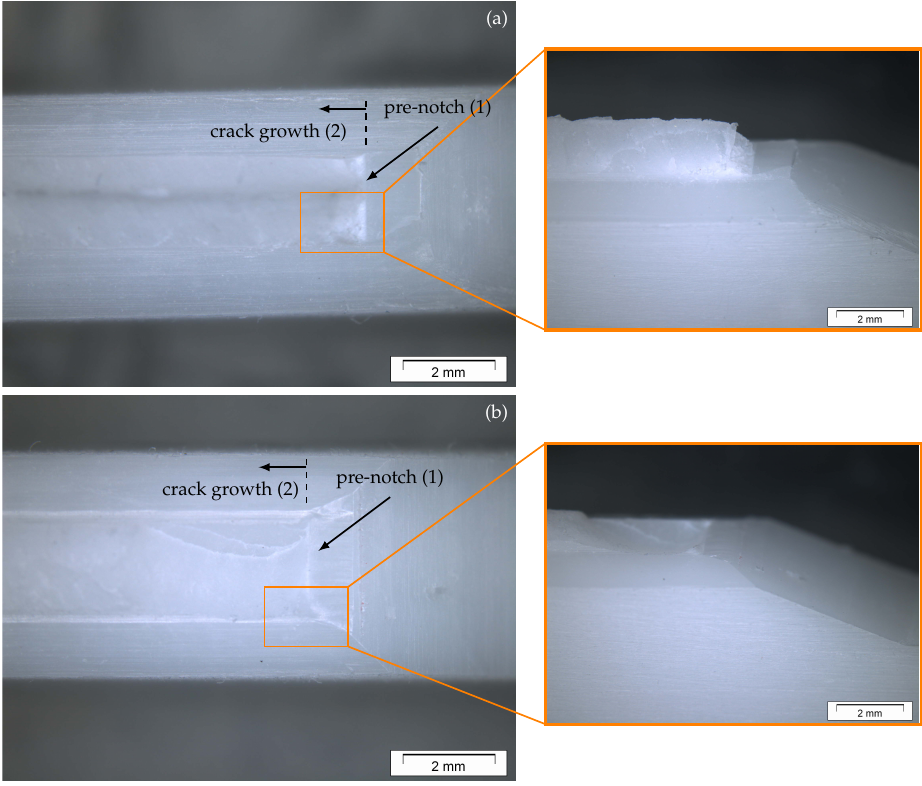
Figure 16. Fracture surface images from two mode III specimens analyzed using a light microscope (16 magnification). Image of a deflected fracture surface ( a ) and a flat fracture surface ( b )—two × different crack areas were observed on the fractured specimen half: pre-notch before testing (1) and area of crack growth during testing